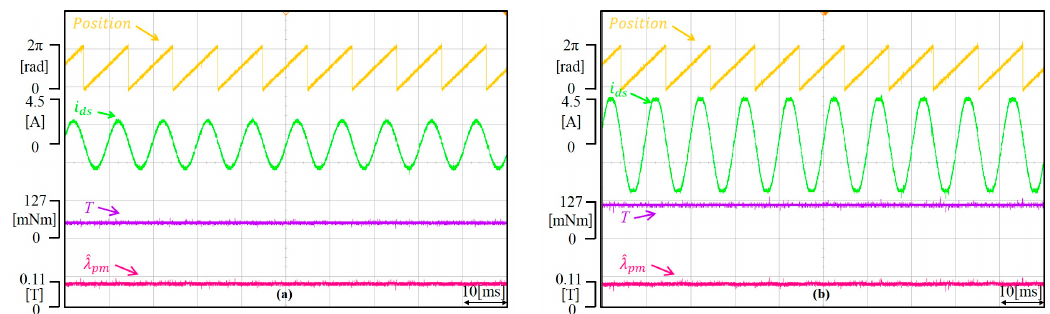
Figure 19. Output current and output torque characteristics according to torque command. ( a ) Torque